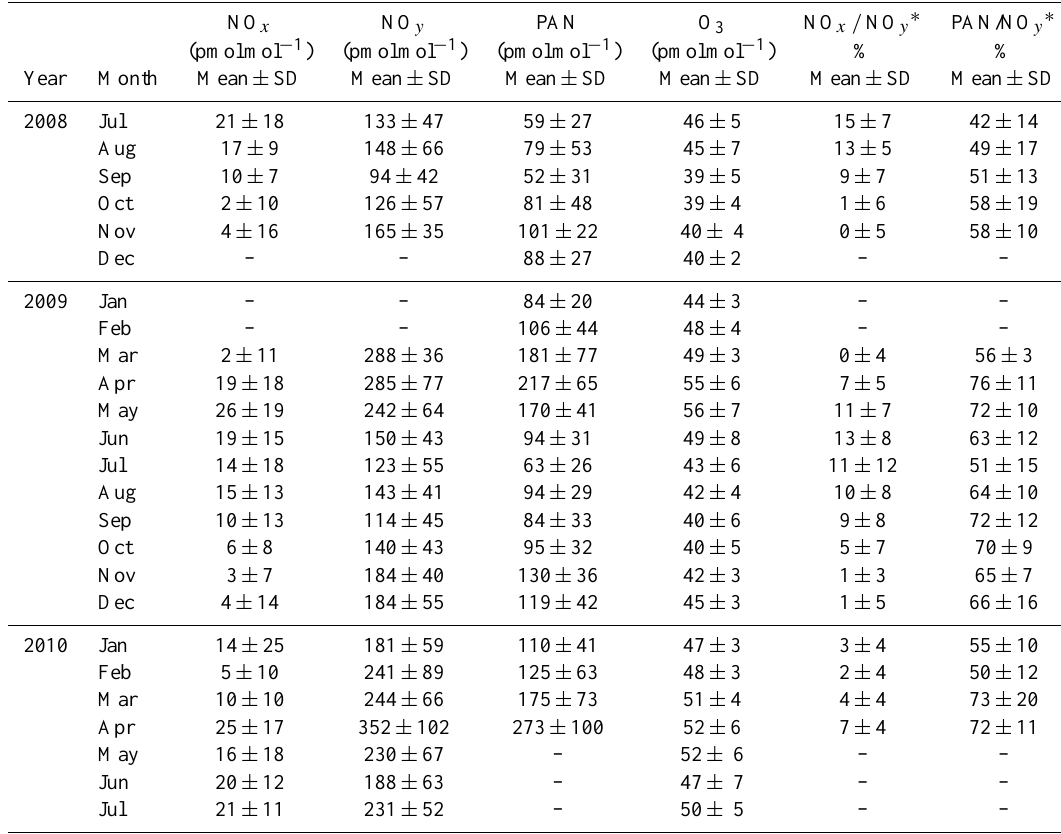
Table 1. Monthly statistics for NO x , NO y , PAN, O 3 , and the NO y budget measured at Summit from 2008 to